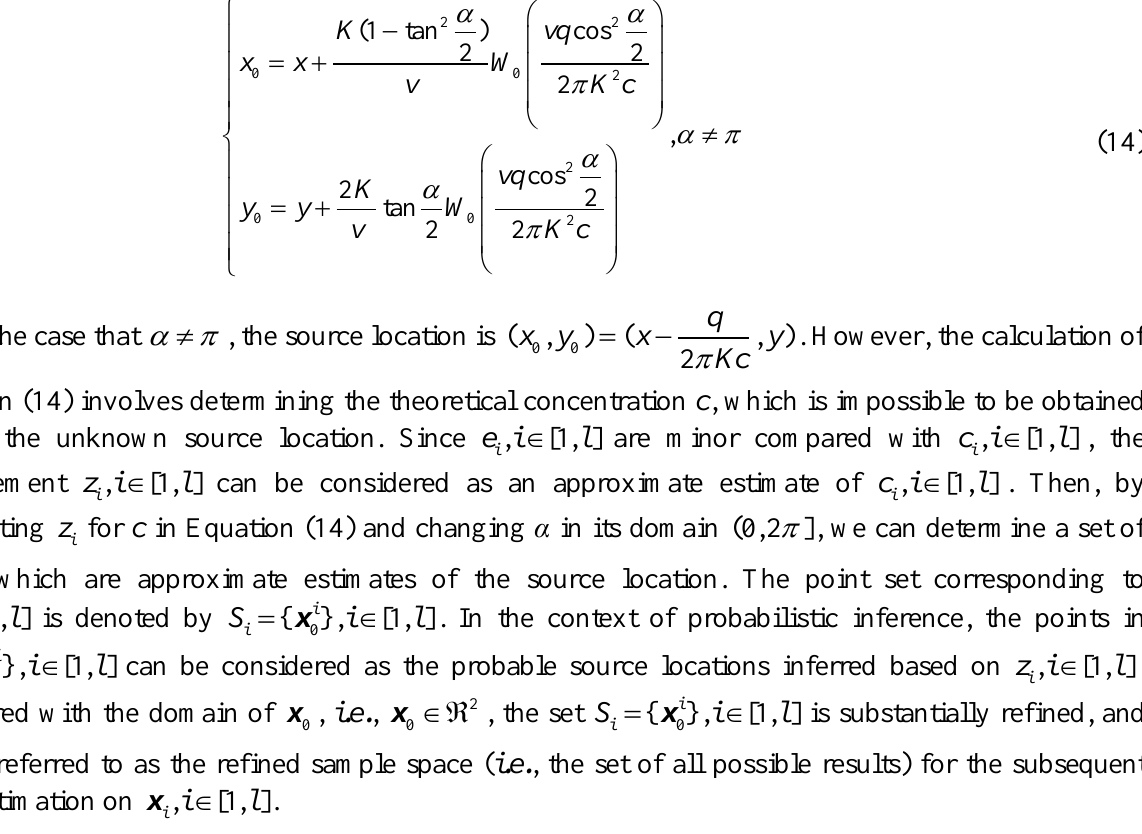
Figure 4. The oval formed by all the points in a single refined sample space, i.e.